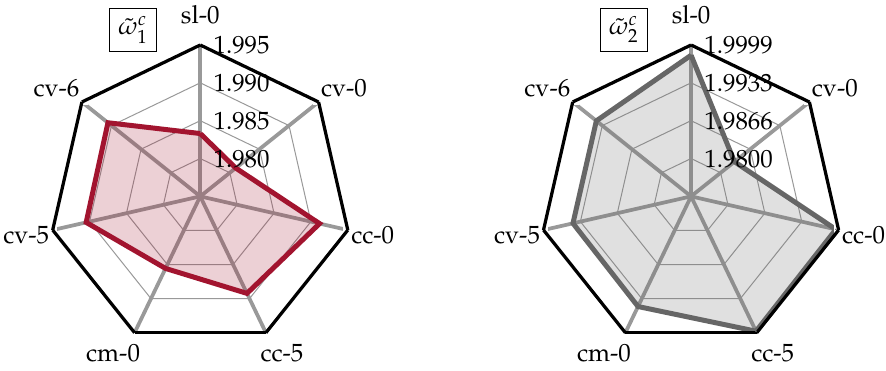
Figure 12. BGK accuracy and stability range comparison for different grid layouts and cv f → c filters. The cell-centered approach cc-5 with linear interpolation of the coarse post-collision distributions in the explosion step shows the highest stability of ˜ ω c = 1.99940 (Re = 6183.25). Even though in the literature explosion, with ˜ ω c h , b 2